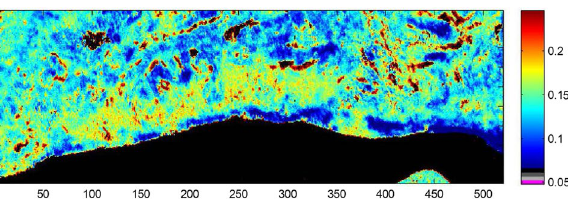
Figure 2. Example of a processed FTIR image. Here the ratio A 1230 /A 1655 is reported, evidencing the epithelial cells surrounding the ducts. The pixels where the SNR is below 150 have been turned to black. This image corresponds to the framed region in the section shown in Fig.